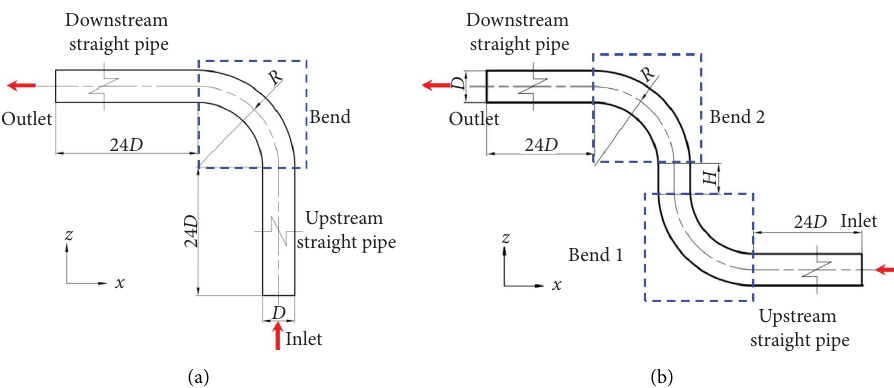
Figure 1: Side view of the pipe 3D calculation domain. (a) L-shaped pipe, (b) Z-shaped pipe. Te red arrows denote the direction of the incoming and outgoing fows at the inlet and outlet,